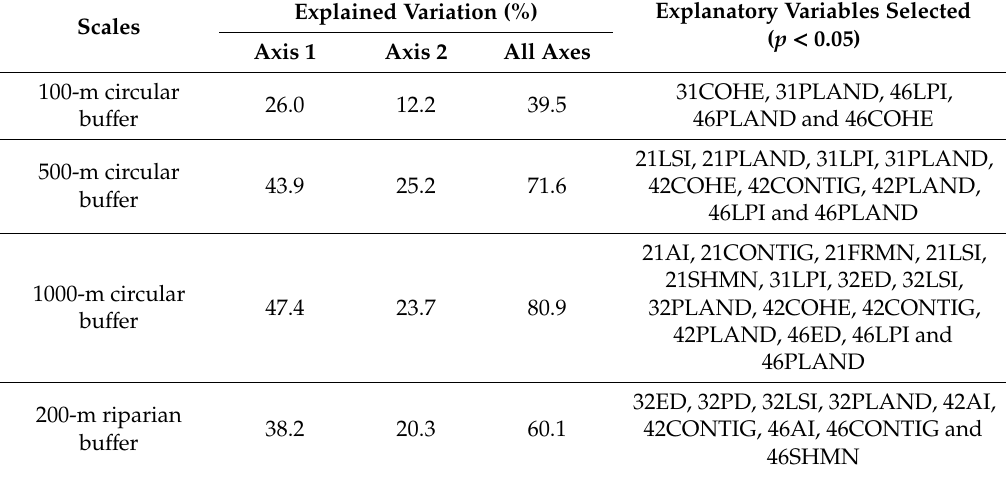
Table 4. Variations in water quality explained by land uses and landscape metrics at di ff erent bu ff er scales in the redundancy analysis